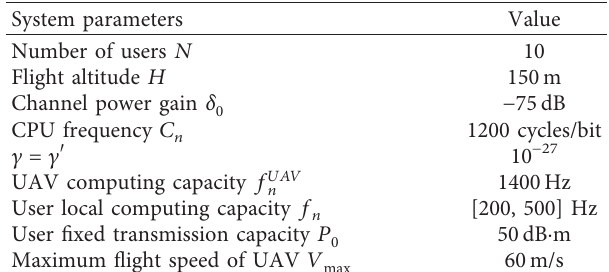
Table 1: System simulation parameters.